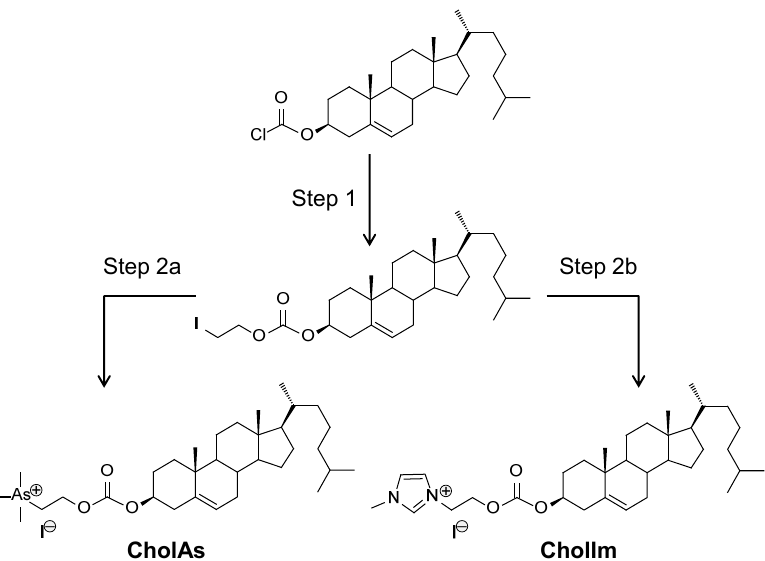
Scheme 1. Two-step synthetic routes for obtaining the cholesterol-based trimethylarsonium cationic lipid CholAs and the cholesterol-based imidazolium cationic lipid CholIm. Step 1: 2-iodoethanol, Et 3 N, CH 2 Cl 2 , 0 °C to RT for 18 h (98% yield); Step 2a: Trimethylarsine, THF, 60 °C for 72 h (60% yield); Step 2b: N -methyl-1,3-imidazole, neat, 40 °C for 20 h (60%